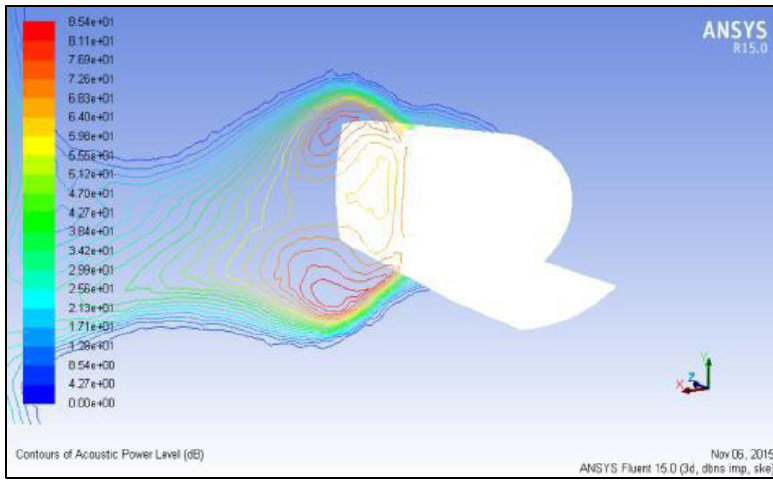
Figure 10. Sound pressure level in X-direction (100 km/h)